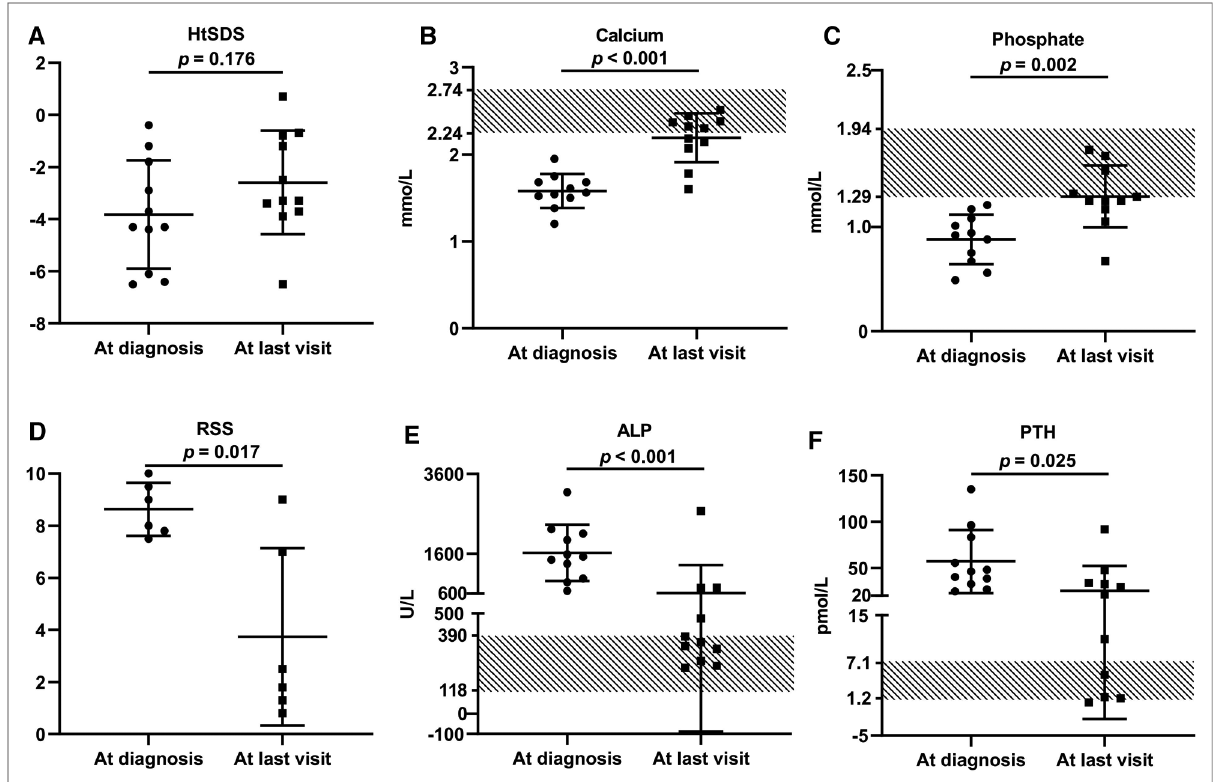
FIGURE 4 Comparison of growth retardation and biochemical changes of 11 VDDR1A children at diagnosis and after treatment. P8 was excluded from this comparison because he was lost in follow-up. ( A ) HtSDS, ( B ) calcium, ( C ) phosphate, ( D ) comparison of RSS of six VDDR1A children (P2, P3, P5, P6, P9, P12), ( E ) ALP, ( F )